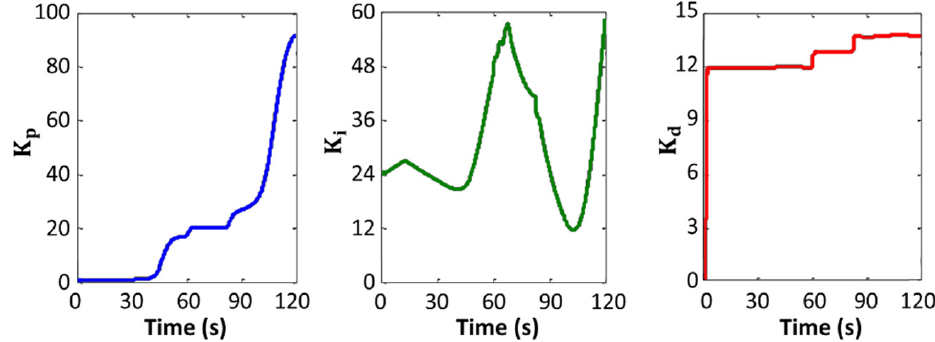
Figure 14. Variations in adaptive gain values of the Y position PID controller.